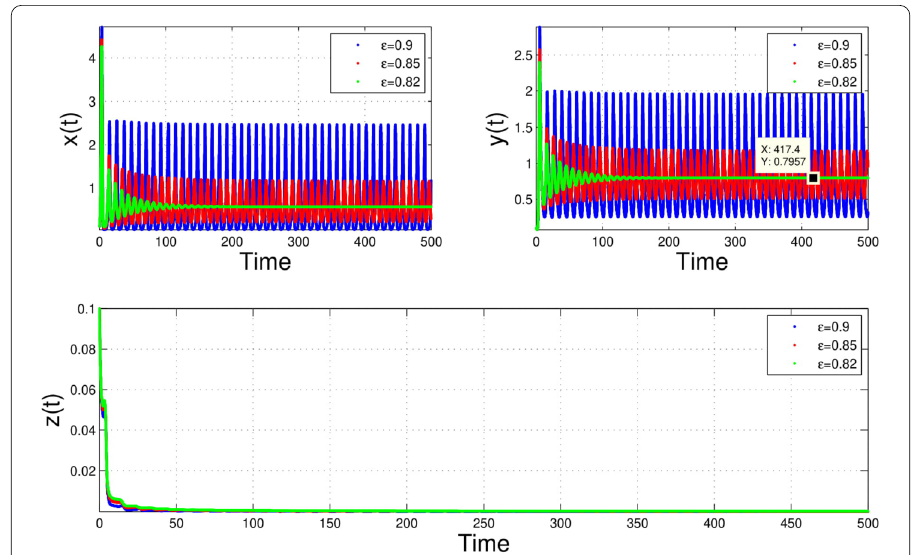
Figure 9 The influence of the memory rate on the stability of the SPFE (cid:7) 2 = (0.56,0.79,0)